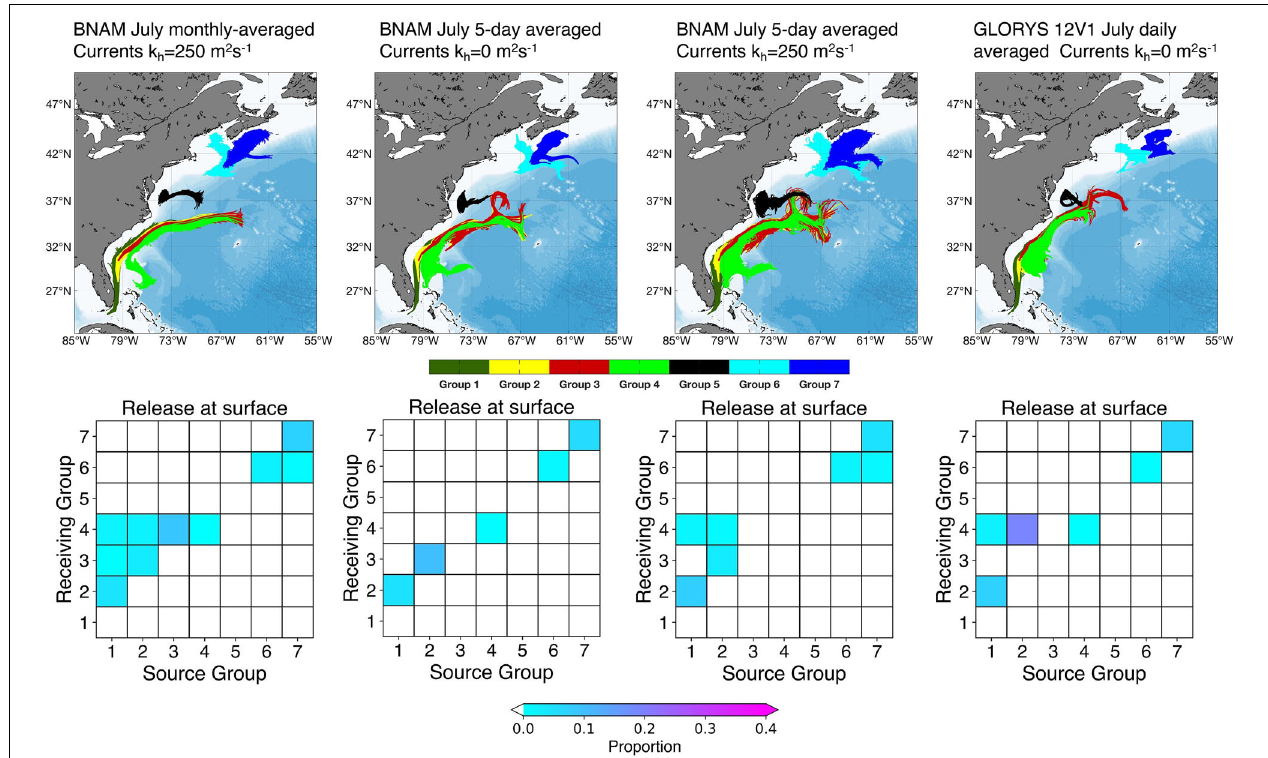
FIGURE 11 | Dispersal kernels and connectivity matrices from particle releases from each of the occupied grid cells in each of the seven Groups ( Table 1 ) from the surface in July 2010, using BNAM monthly averaged currents (k h = 250 m 2 s − 1 ), BNAM 5-day averaged currents (k h = 0 m 2 s − 1 and k h = 250 m 2 s − 1 ) and GLORYS12VI daily averaged currents (k h = 0 m 2 s − 1 ) in the particle tracking